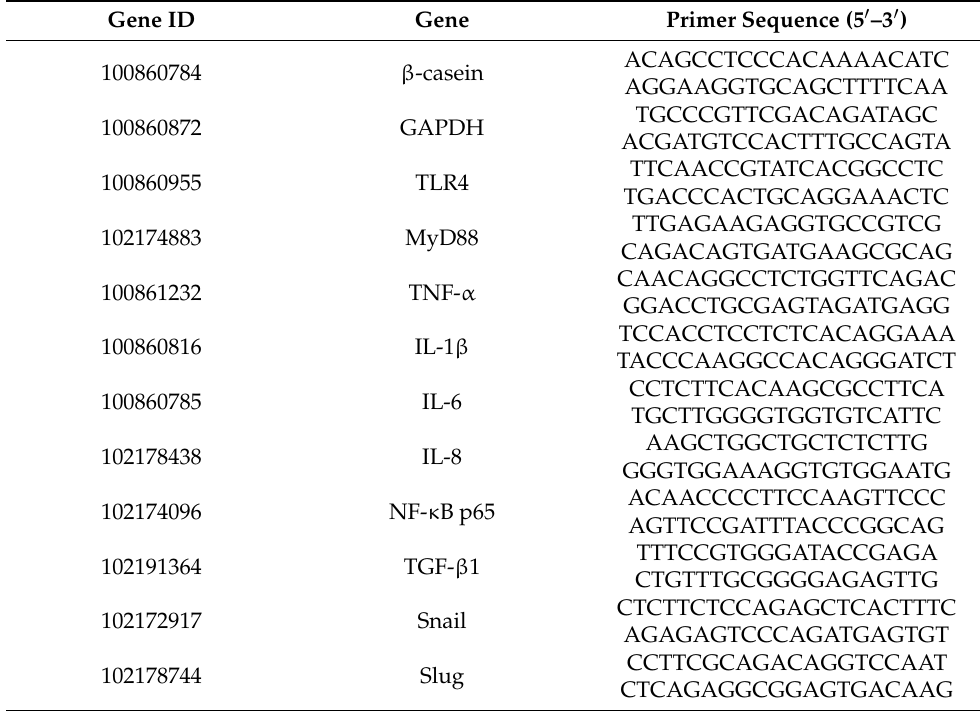
Table A1. Primer sequence for qRT-PCR.